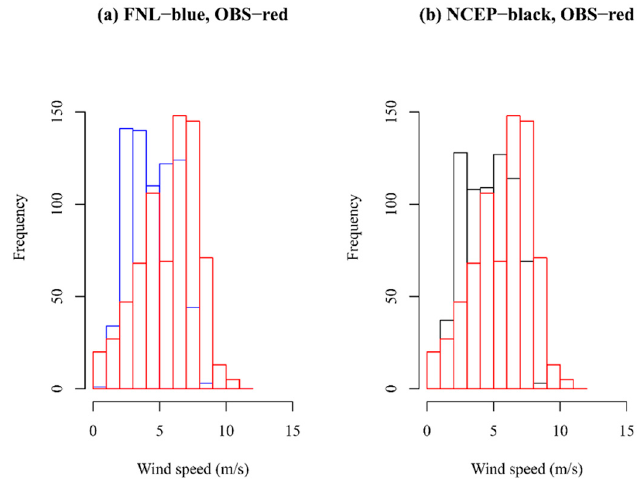
Figure 10. Histograms of 10 m level wind speed at Crown Point as simulated by WRF using FNL as input atmospheric conditions (in blue), with NCEP as input (in black) as compared against in-situ observations (in red).